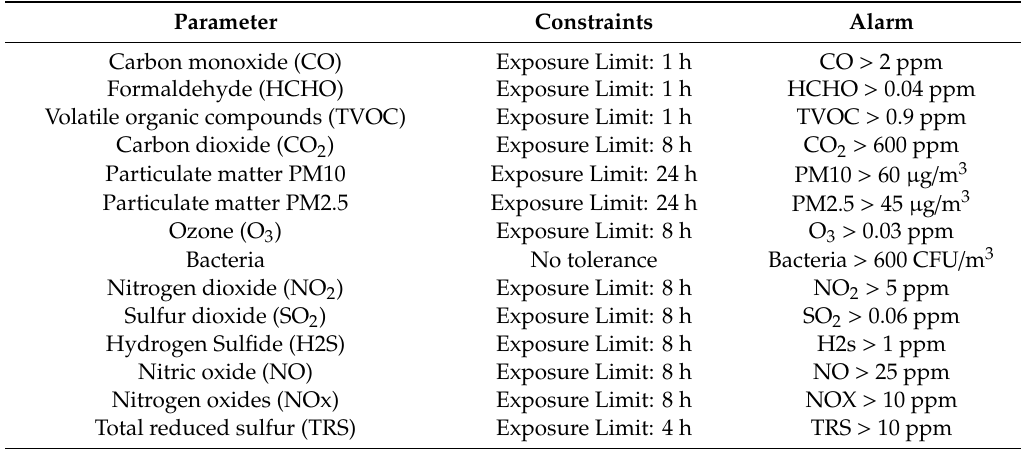
Table 9. Pollutants alarms and constraints for a specific Table 11. Pollutants alarms and constraints for a specific profile.